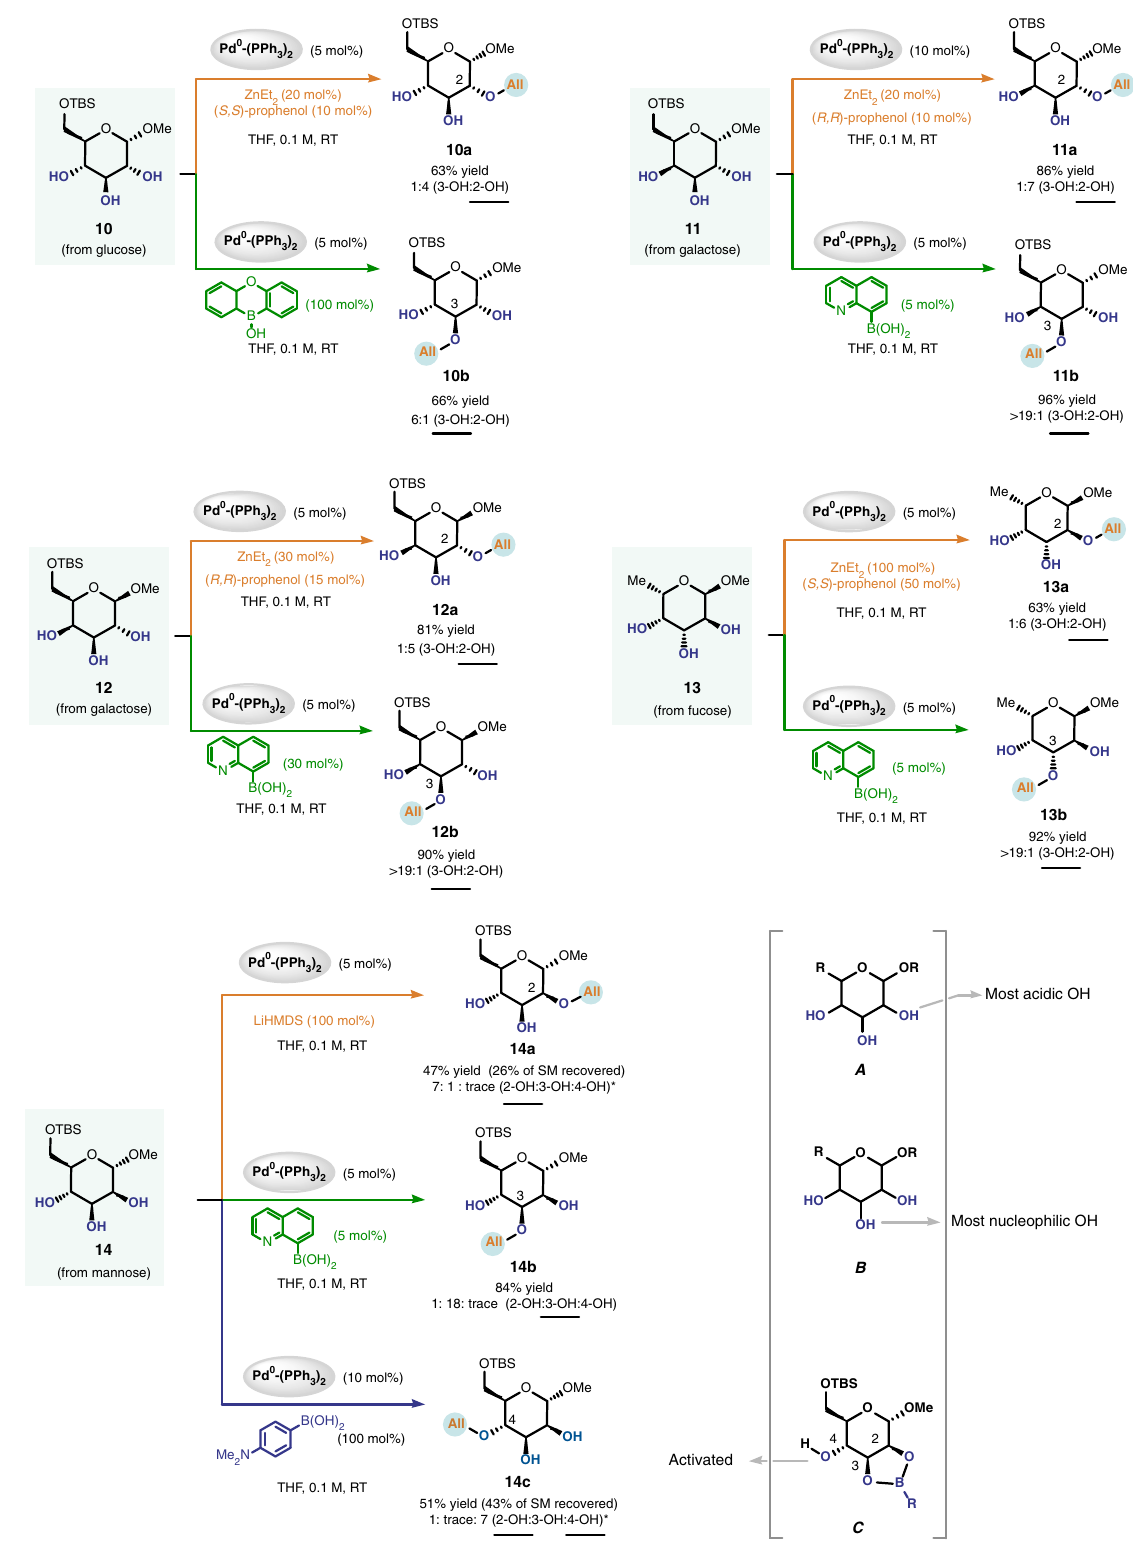
Fig. 3 Site-switchable mono- O -allylation of monosaccharides. Product ratios were determined by 1 H NMR analysis of crude reaction mixtures. Reported yields are isolated yields of products that are underlined. * A small amount of diallylated product was formed. See Supplementary Information for experimental details. L